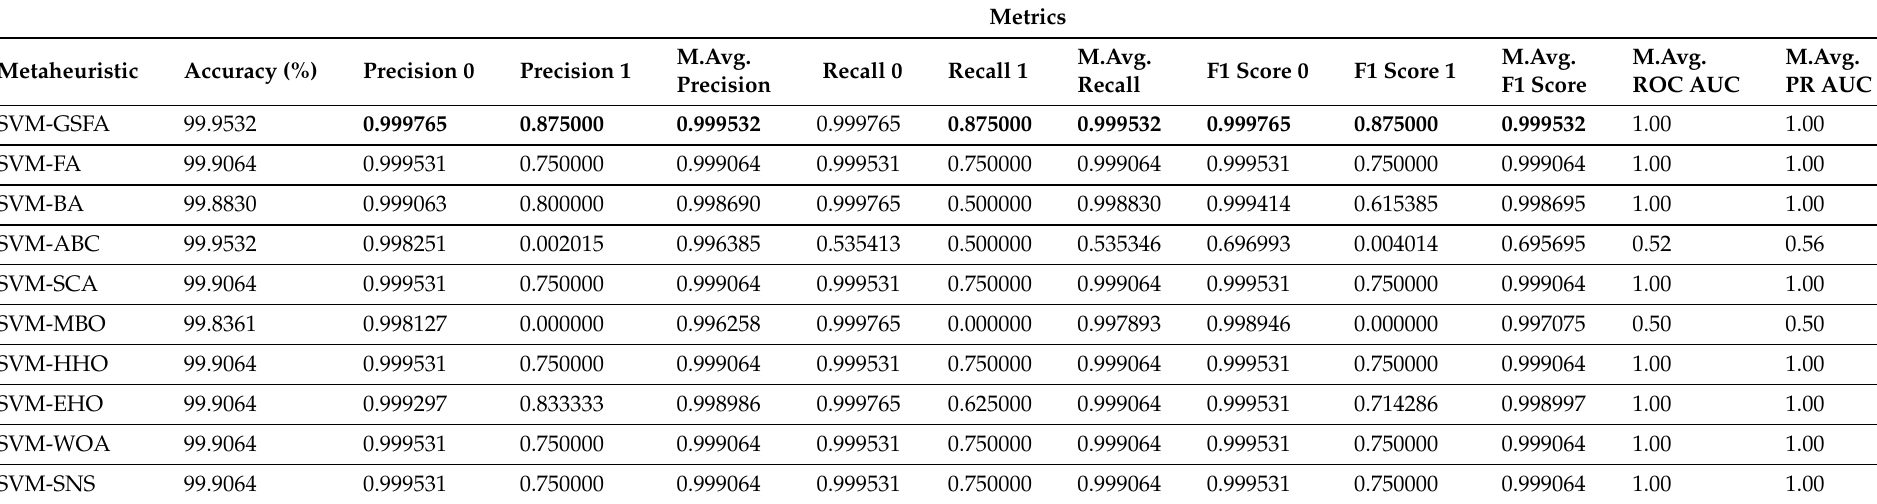
Table 8. SVM Credit Card Fraud small NO SMOTE—detailed metrics.